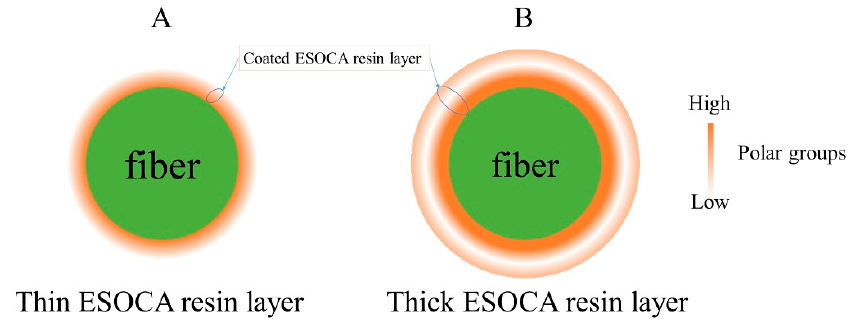
Scheme 3. Distributions of polar groups in ESOCA resins with different thicknesses.